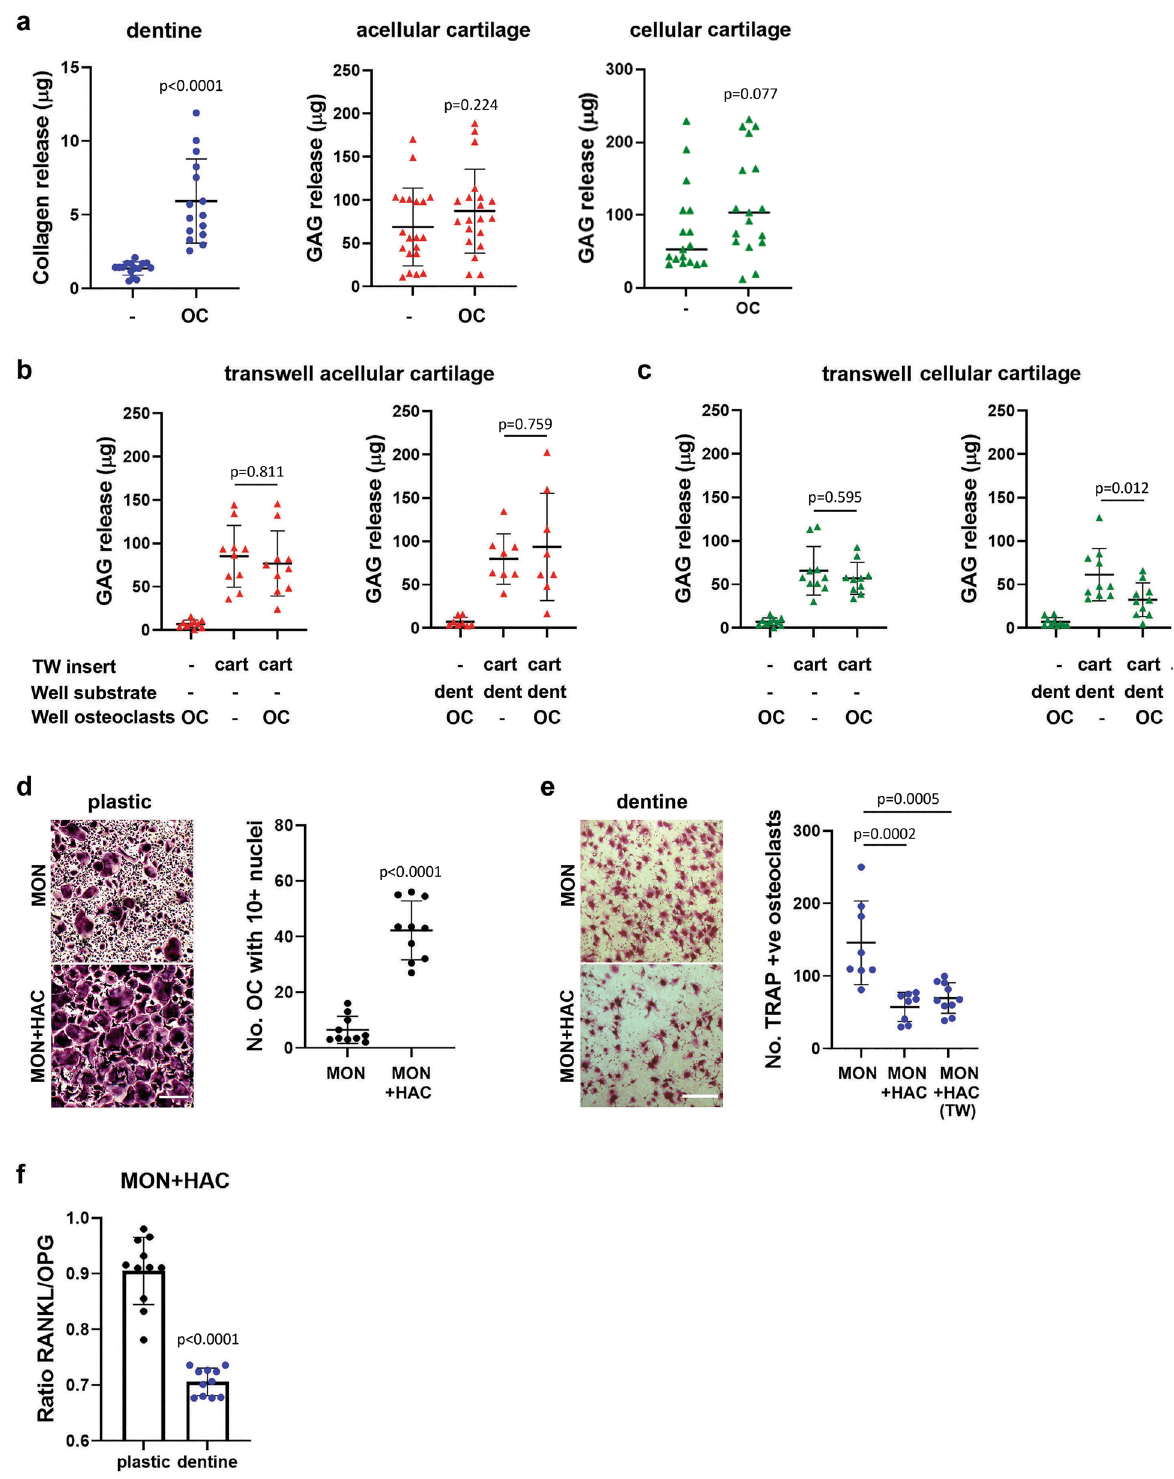
Figure 2. Substrate-dependent regulation of osteoclasts by chondrocytes. ( a ) Osteoclast-mediated release of (left, n = 16; T test) collagen from dentine and release of GAG from (middle, n = 20; T test) acellular or (right, n = 17; Mann– Whitney) cellular cartilage after 13 days of differentiation. ( b , c ) GAG release from indirect co-culture experiments with osteoclasts differentiated on either plastic or dentine for 13 days with pieces of ( b ) acellular cartilage or ( c ) cellular cartilage in a Transwell insert. (n = 10; both one-way ANOVA) ( d , e ) TRAP-staining following 10 days’ differentiation of CD14 + monocytes into osteoclasts by direct co-culture with chondrocytes and exogenous M-CSF and RANKL. Differentiation performed on ( d ) cell culture plastic (scale bar = 400 µm) with quantification of the number of TRAP- positive cells with ≥ 10 nuclei (n = 10; T test) or ( e ) dentine discs (scale bar = 500 mm) with quantification of the total number of TRAP-positive cells (n = 8; one-way ANOVA). ( f ) Expression ratio of RANKL:OPG in direct co-cultures of osteoclasts and chondrocytes on plastic or dentine (n = 11; T